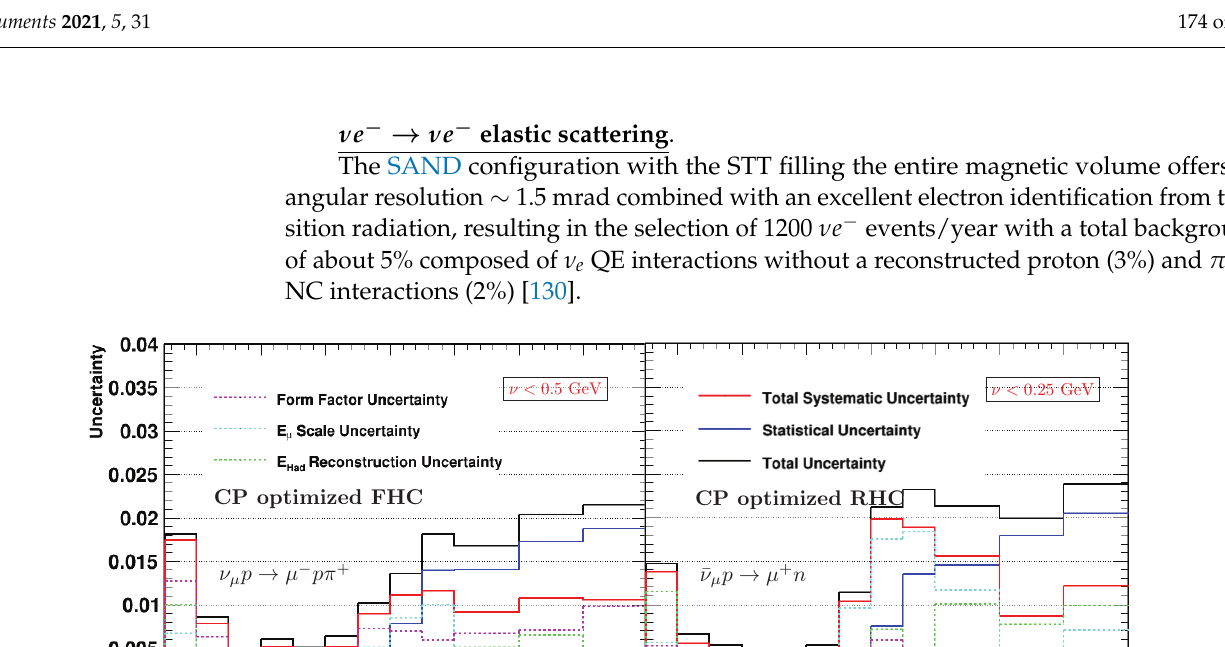
µ + n exclusive processes →